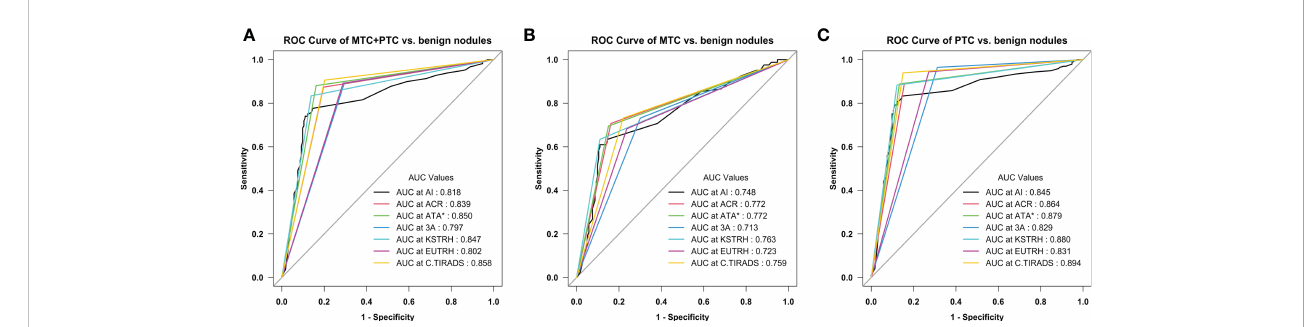
FIGURE 1 Receiver operating characteristic (ROC) curves of the seven diagnostic methods (A) Medullary thyroid carcinoma (MTC) + papillary thyroid carcinoma (PTC) vs. benign nodules; (B) MTC vs. benign nodules; (C) PTC vs. benign nodules. *Excluding the nodules that are not classi fi able using the ATA system (5 MTC, 17 PTC, and 22 benign nodules).